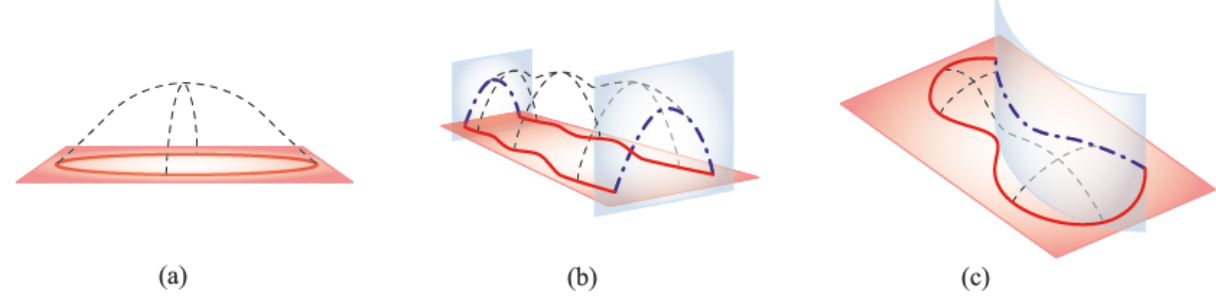
Figure 1: Definition of CG (a) and PG cut by vertical planes (b) and curved surface (c) (after Venuti and Bruno [31])